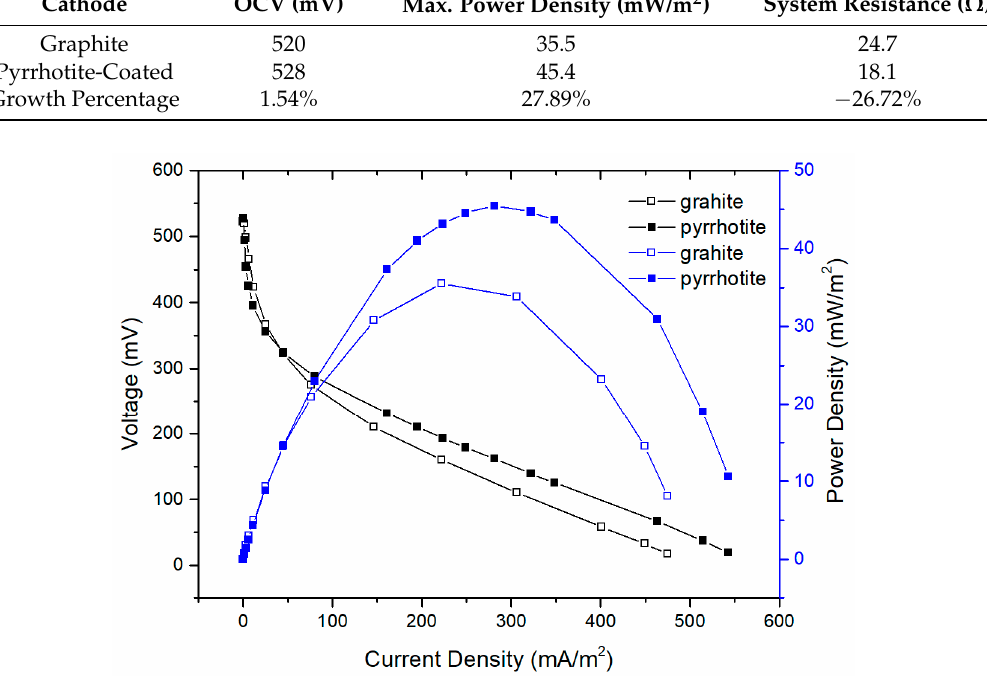
Figure 2. Polarization and power density curves of MFCs with pyrrhotite and graphite cathodes.